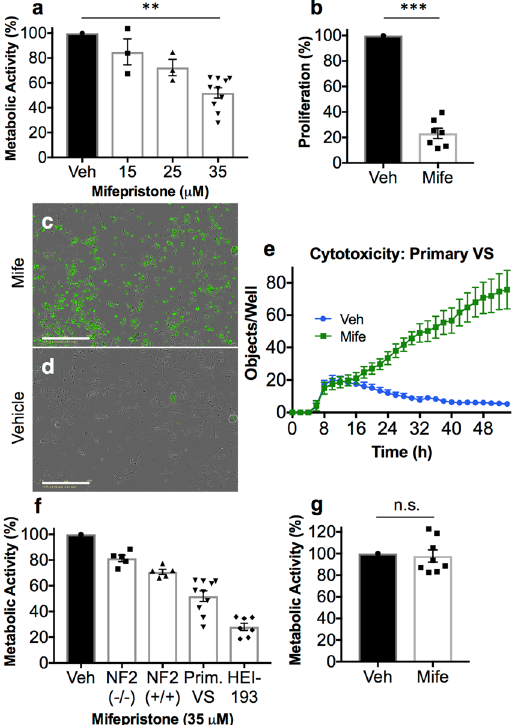
Figure 4. Mifepristone adversely affects primary human VS cells and human-derived arachnoid cells in culture, but leaves primary human Schwann cells unaffected. ( a ) Metabolic activity of primary VS cells declines with increasing concentrations of mifepristone; individual data points represent metabolic activity as percentage of vehicle-treated control for ten individual tumors, performed in replicates of 3–5 wells per condition (vehicle- treated cells versus 35 μ M mifepristone-treated cells, p = 0.002; ** p < 0.01). ( b ) Quantification of the significant decline in BrdU incorporation observed in primary VS cells treated with 35 μ M mifepristone (p = 0.0002; *** p < 0.001). ( c – e ) Live cell fluorescence microscopy reveals a significant increase in cytotoxicity of VS cells under mifepristone treatment; representative data from a single tumor, quantified from nine replicate images per treated well, performed in quadruplicate for each treatment condition: ( c ) Primary human VS cells imaged at 10X after treatment with 35 μ M mifepristone for 72 hours, where cytotoxicity is indicated via green fluorescent signal; ( d ) Vehicle-treated control cells (DMSO 0.1%); ( e ) Quantification of cytotoxicity, reported as number of green objects per well after thresholding to exclude small cellular debris. ( f ) Mifepristone reduces the metabolic viability of schwannoma cells more significantly than that of AC-CRISPR NF2( − / − ) and AC-CRISPR NF2( + / + ) human arachnoid cells. ( g ) Mifepristone does not adversely affect the metabolic viability of primary human Schwann cells in culture (n = 8, p = 0.23). Center values in histograms are means; error bars are